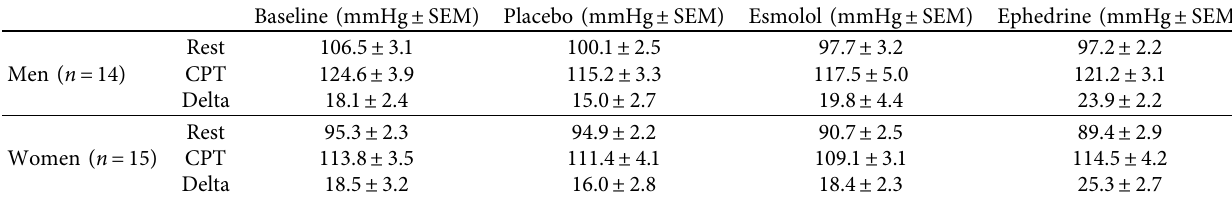
Table 4: Mean arterial blood pressure for men and